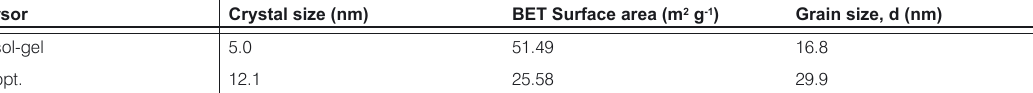
powders calcined at 2